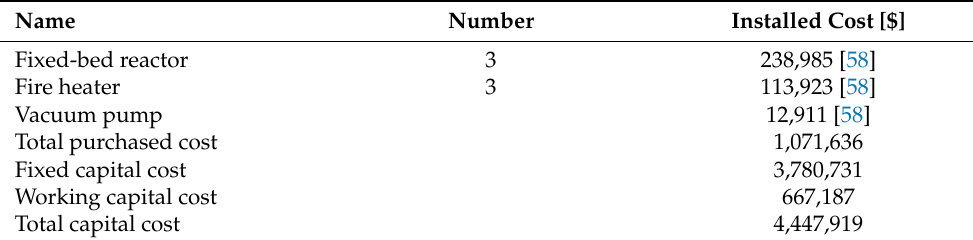
Table 8. Scenario 2 semi-regenerative process total capital cost.